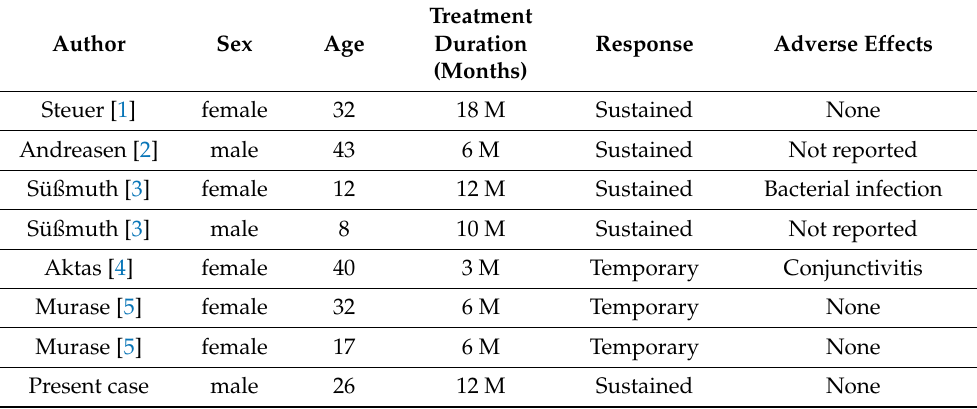
Table 1. List of previously reported cases of Netherton syndrome treated with dupilumab. A total of eight cases (including the present case) have been reported to date. Three patients developed resistance to